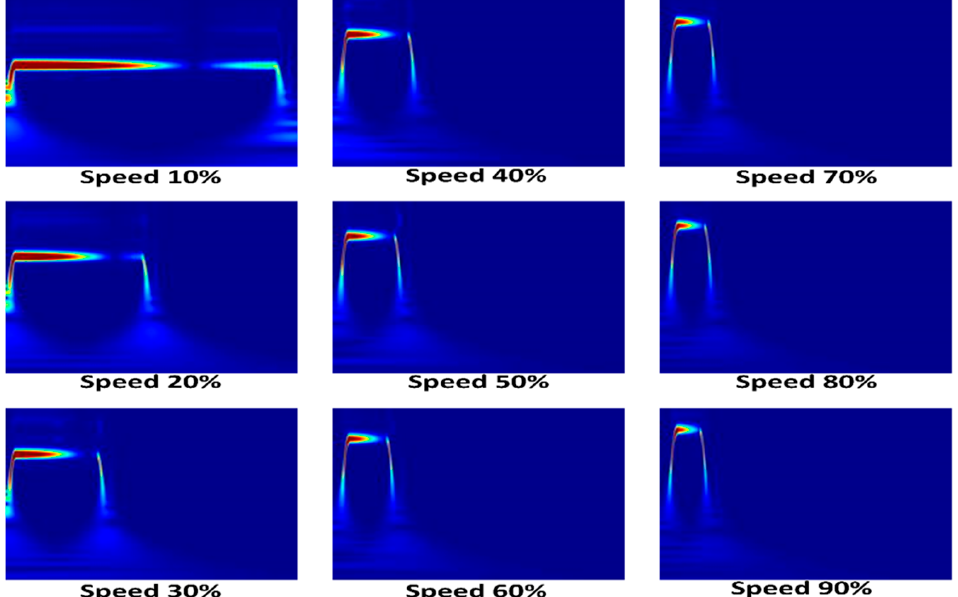
Figure 14. Scalogram images for multiple speed domains for a single cycle.